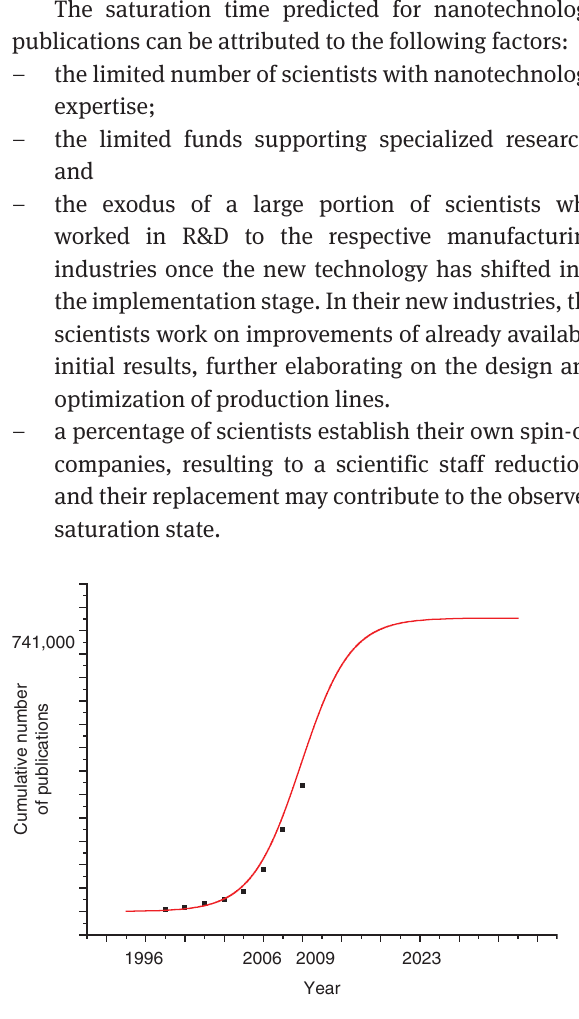
Figure 7 Forecast for the evolution of nanotechnology using scien- tific publications as a measure.